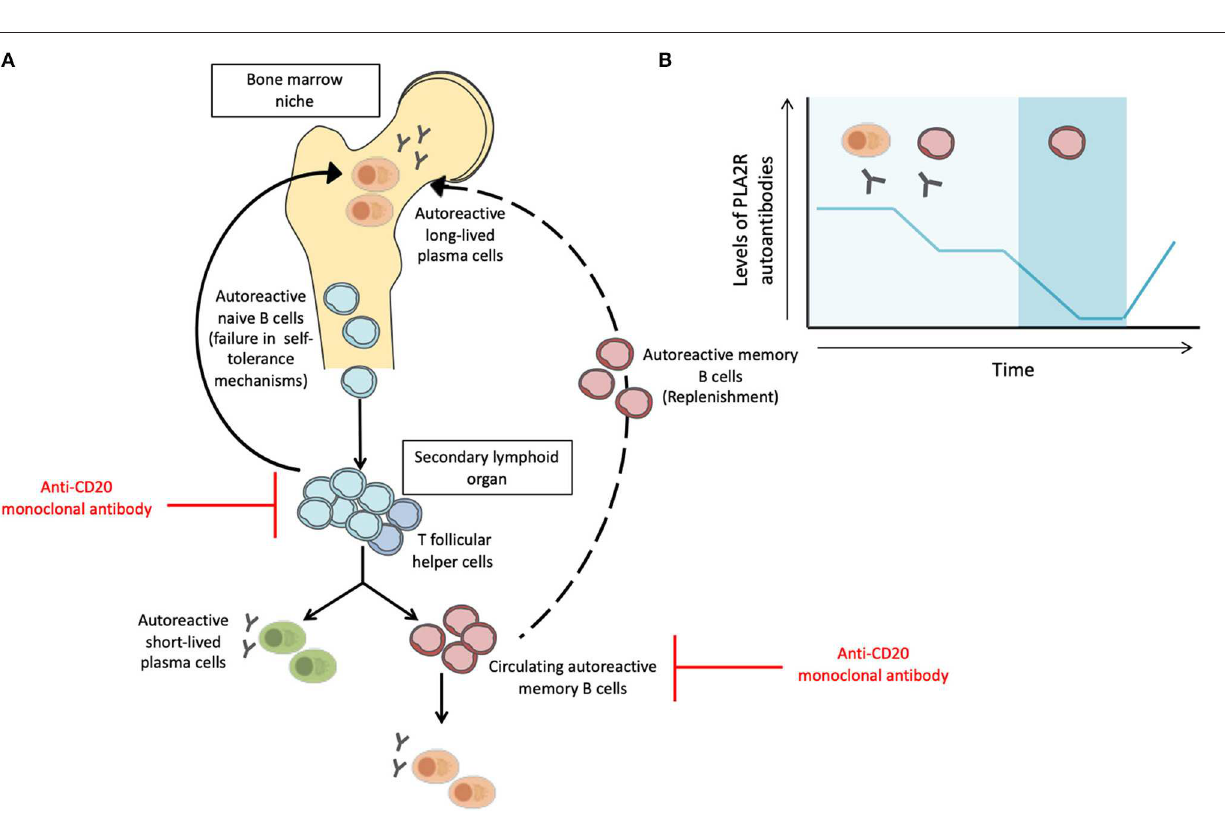
FIGURE 1 | Activation and inhibition of autoimmune B cell responses and the influence of different B cell subsets in the fluctuation of circulating anti-PLA 2 R antibodies. (A) After failure in self-tolerance mechanisms, autoreactive naïve B cells may encounter the self-antigen and can be activated in the secondary lymphoid organ by helper signals from T follicular helper cells. Then, B cells can differentiate into short-lived plasma cells, which secrete mainly IgM antibodies or differentiate into memory B cells or long-lived plasma cells after somatic hypermutation and immunoglobulin isotype class switching in the germinal center. After a re-encounter with the self-antigen, memory B cells can rapidly differentiate into antibody-secreting cells, sustaining long-lasting humoral immunity. Memory B cells may occupy empty bone marrow niches after secondary activation replenishing plasma cell pool. Anti-CD20 monoclonal antibodies (Rituximab) mainly target naïve B cells and memory B cells but not long-lived plasma cells. (B) Levels of anti-PLA 2 R autoantibodies may fluctuate over time and may become undetectable without indicating MN remission. Memory B cells can be detected in the absence of antibody levels in serum and its rapid differentiation and production of antibodies can be of great importance for a subsequent humoral response. Such effective and rapid response of the memory-B cell population indicates that although anti-PLA 2 R autoantibodies may not be detected in serum, PLA 2 R-specific memory B cells can be a target indicator of MN